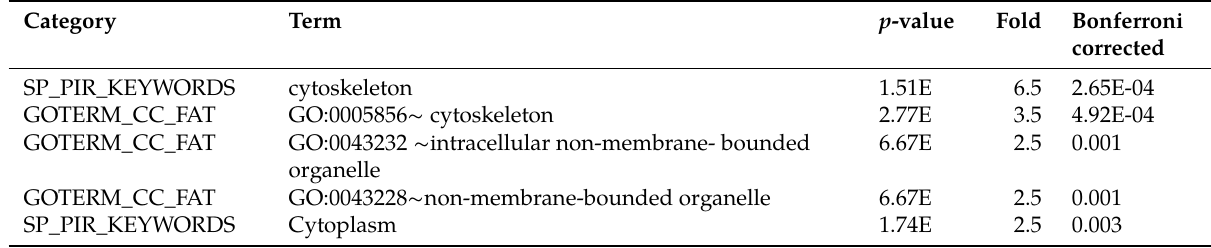
Table 1: GO categories (compartments) for differential isoforms.